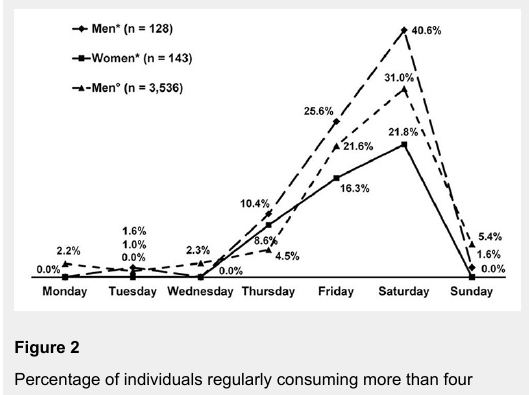
Percentage of individuals regularly consuming more than four drinks on a single occasion in the last 30 days by gender and day of the week. Note: *mean age = 23.1 years, standard deviation = 3.1 years, data taken from Kuntsche and Labhart [23]; °19-year-olds, data taken from Gmel et al.